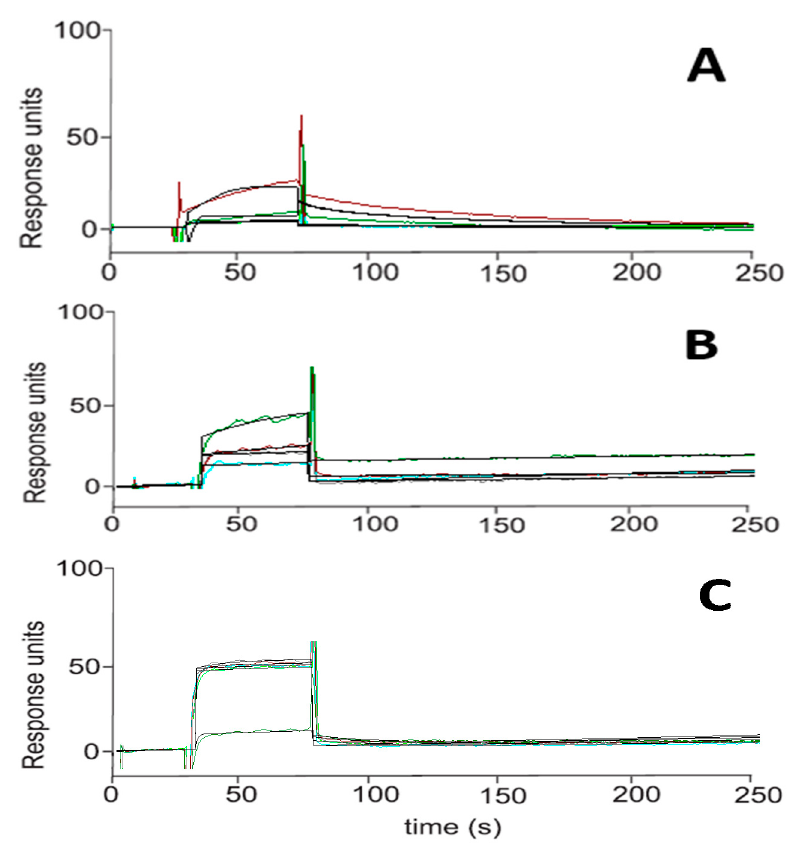
Figure 6. Surface plasmon resonance sensorgram acquired for HAA 2021 ( A ) interacting with Hsp90 α and for the positive controls radicicol ( B ) and 17-AAG ( C ). Each compound was injected onto the Hsp90 α modified sensor chip at six different concentrations in the range of 0.025–4.000 µ M. X-axis: time (s), y-axis: response units. Table 3. Thermodynamic constants (mean ± sd) measured by SPR for the interaction between the tested compounds and immobilized Hsp90 α